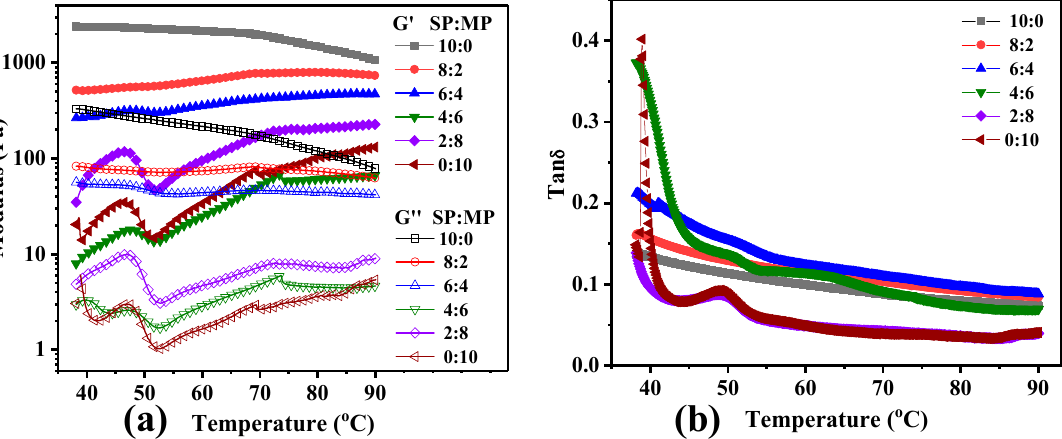
Figure 5. Rheology properties of ( a ) storage modulus G’ and loss modulus G’’; and ( b ) tan δ of the SP and MP system with various SP/MP proportions at different heating temperatures.